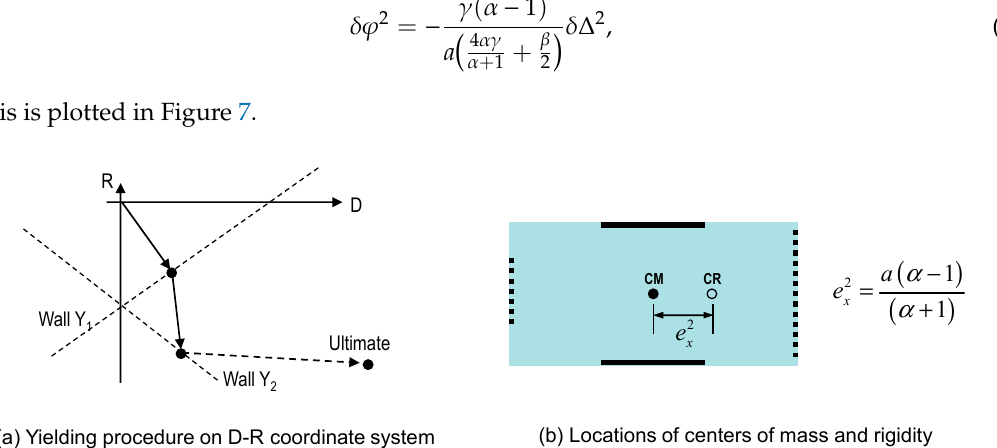
Figure 7. Yielding procedure: Second inelastic stage.